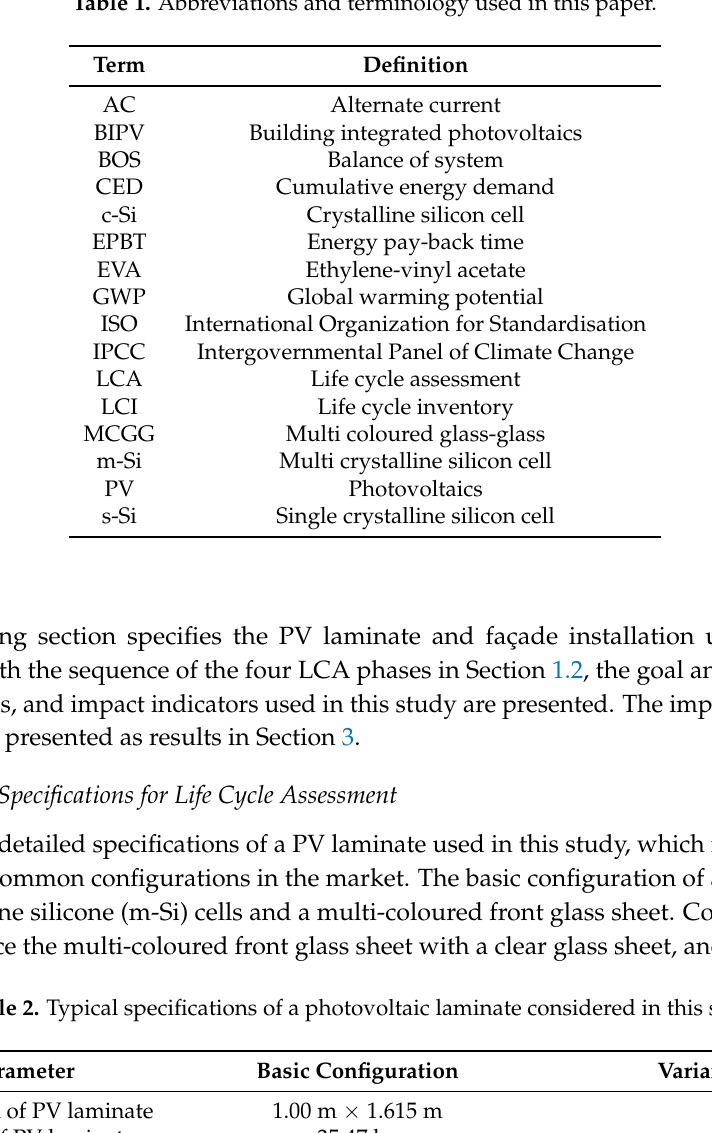
Table 1. Abbreviations and terminology used in this paper.